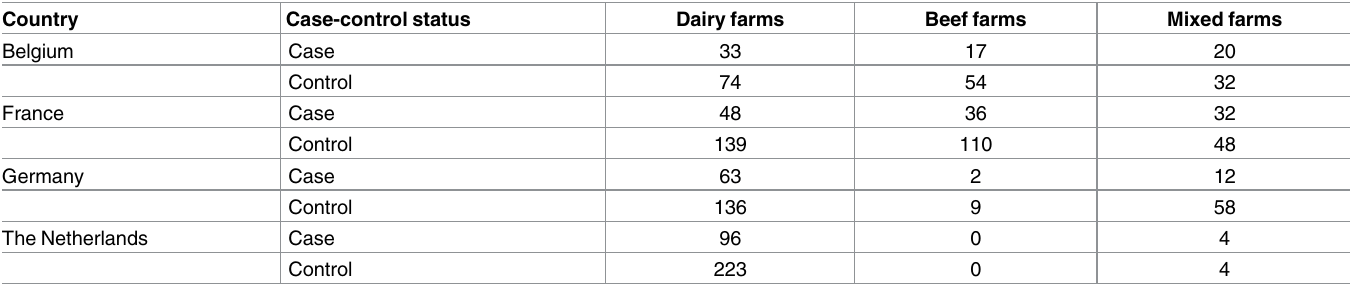
Table 2. Production type of farms included in multi-country BNP casecontrol